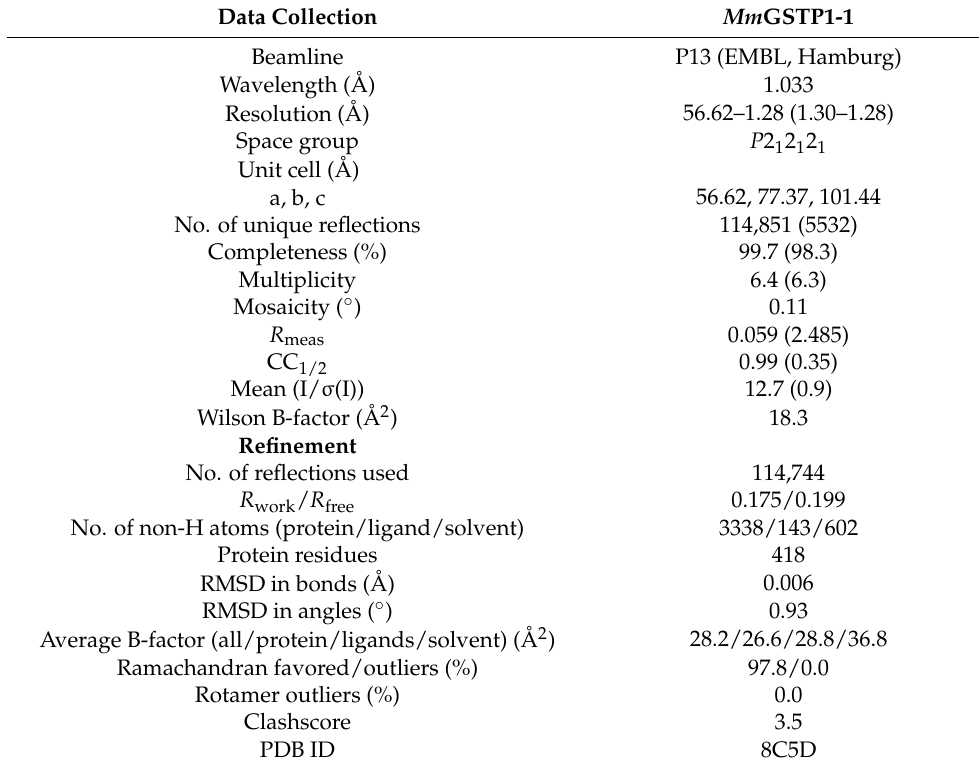
Table 2. X-ray data collection and refinement